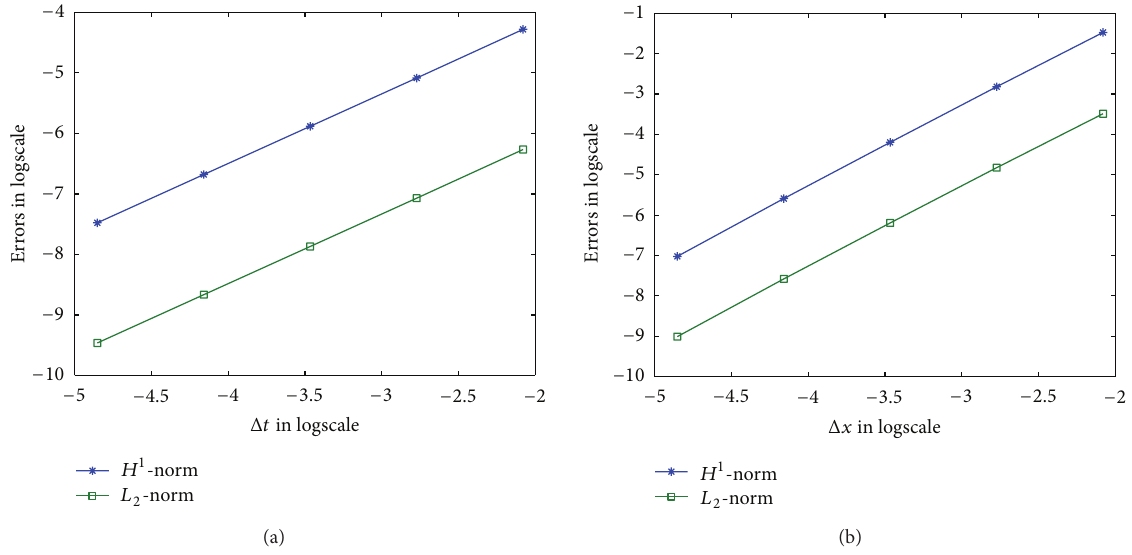
Figure 1: 𝐻 1 -norm and 𝐿 2 -norm of errors for (46) with 𝛼 = 0.9 , 𝛽 = 0.5 , Δ𝑥 = 0.001 (a), and Δ𝑡 = 0.001 (b).